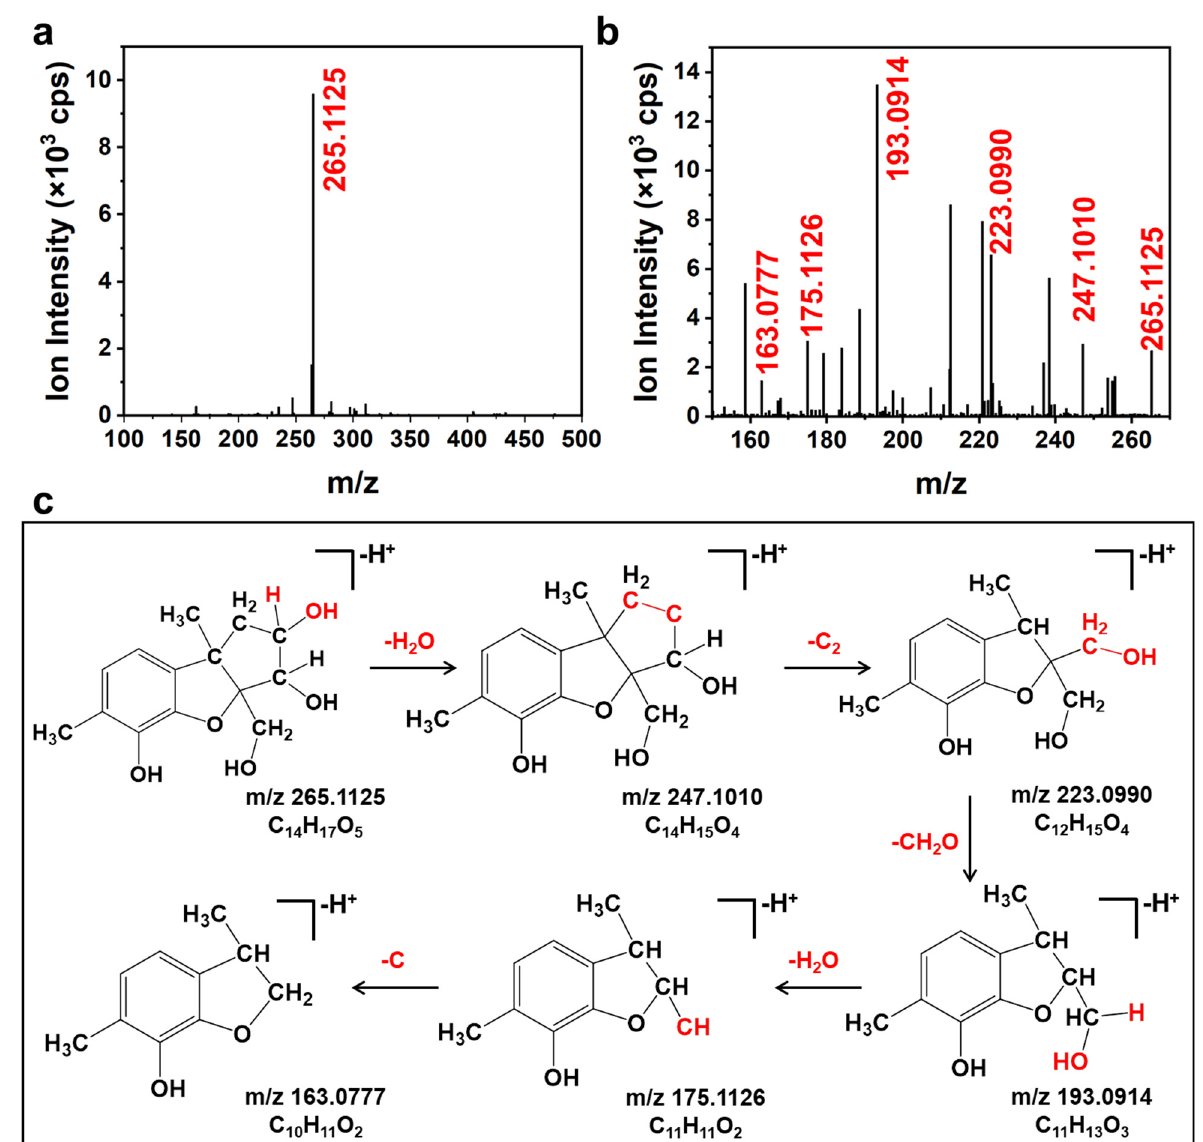
Figure 4. TOF MS spectra ( a ), TOF MS-MS spectra, ( b ) and possible fragments ( c ) of norDON B obtained by alkali treatment.